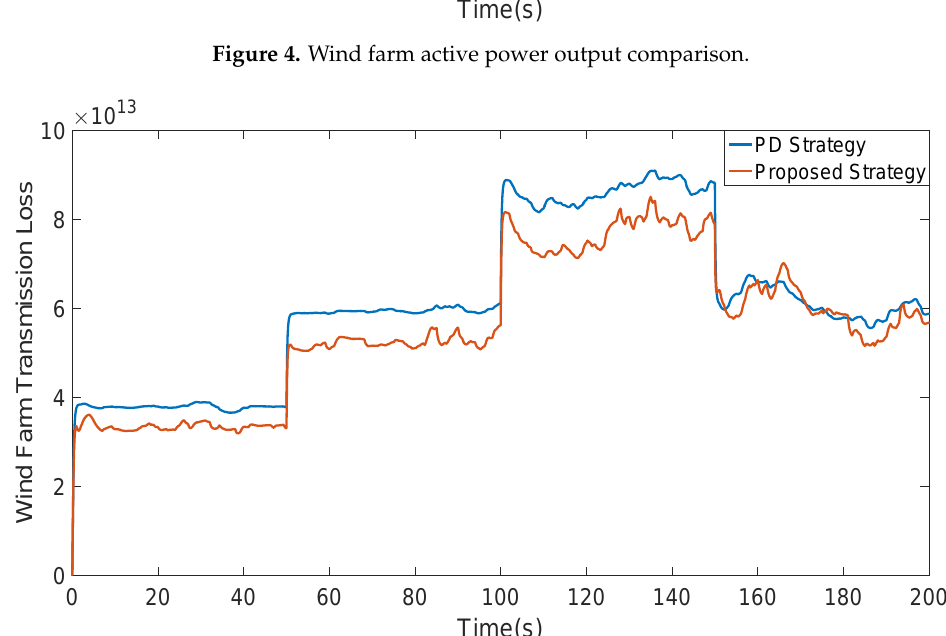
Figure 5. Wind farm transmission loss